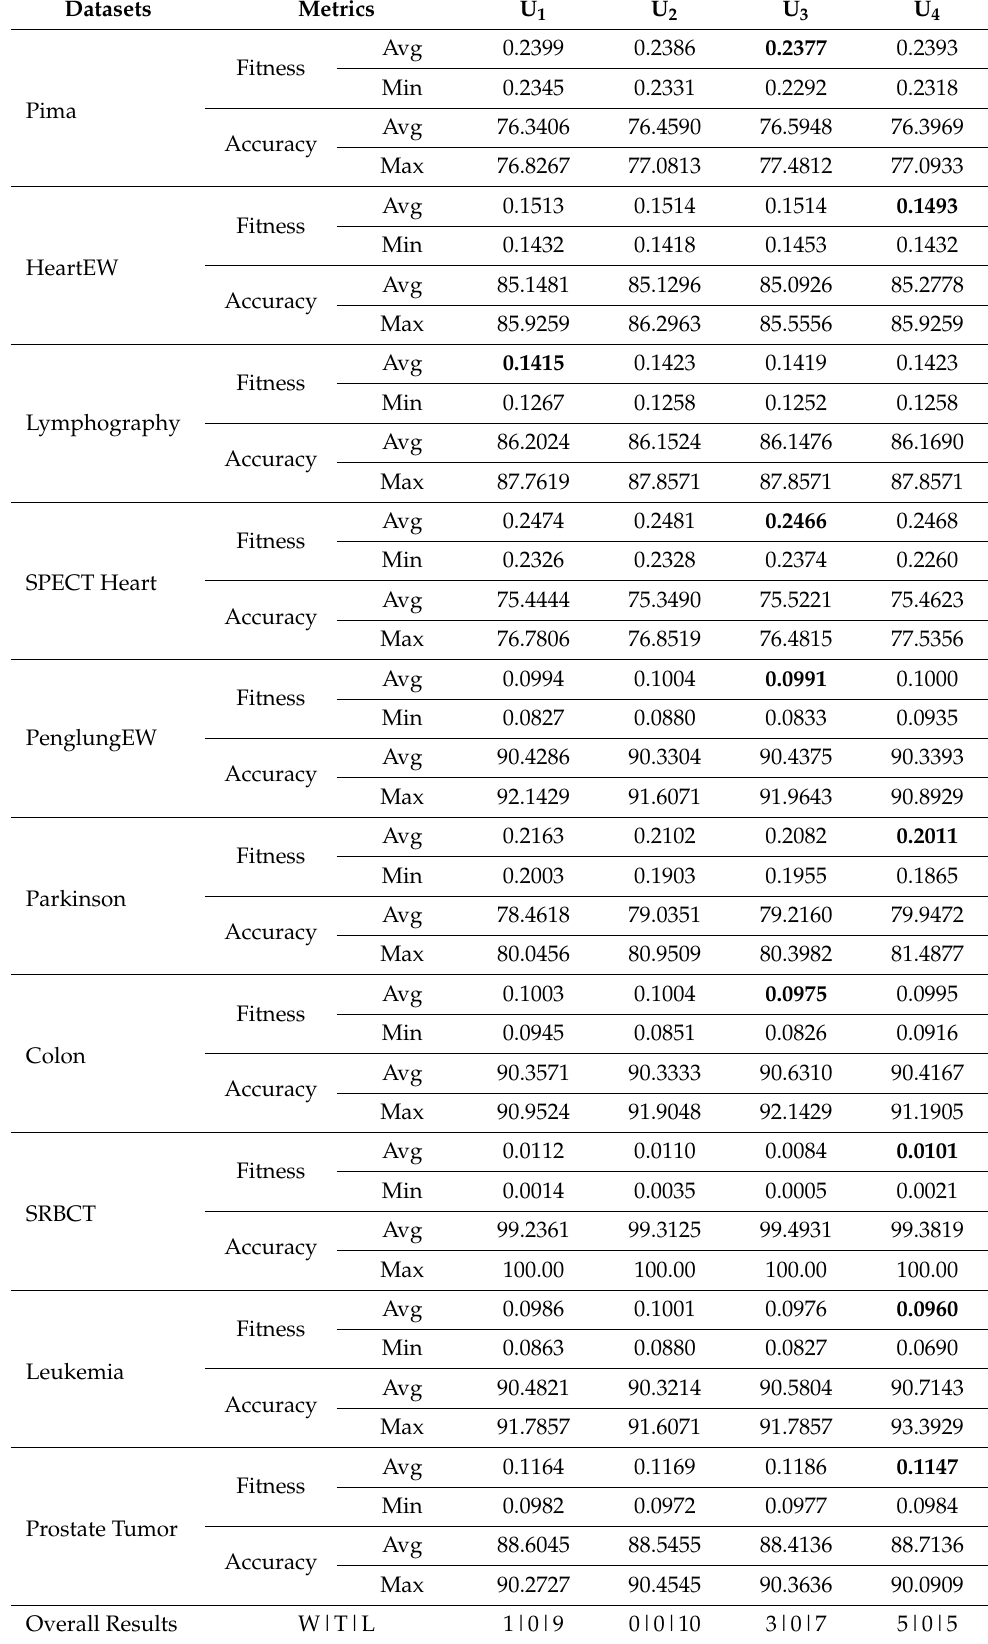
Table A3. The comparison results between different versions of